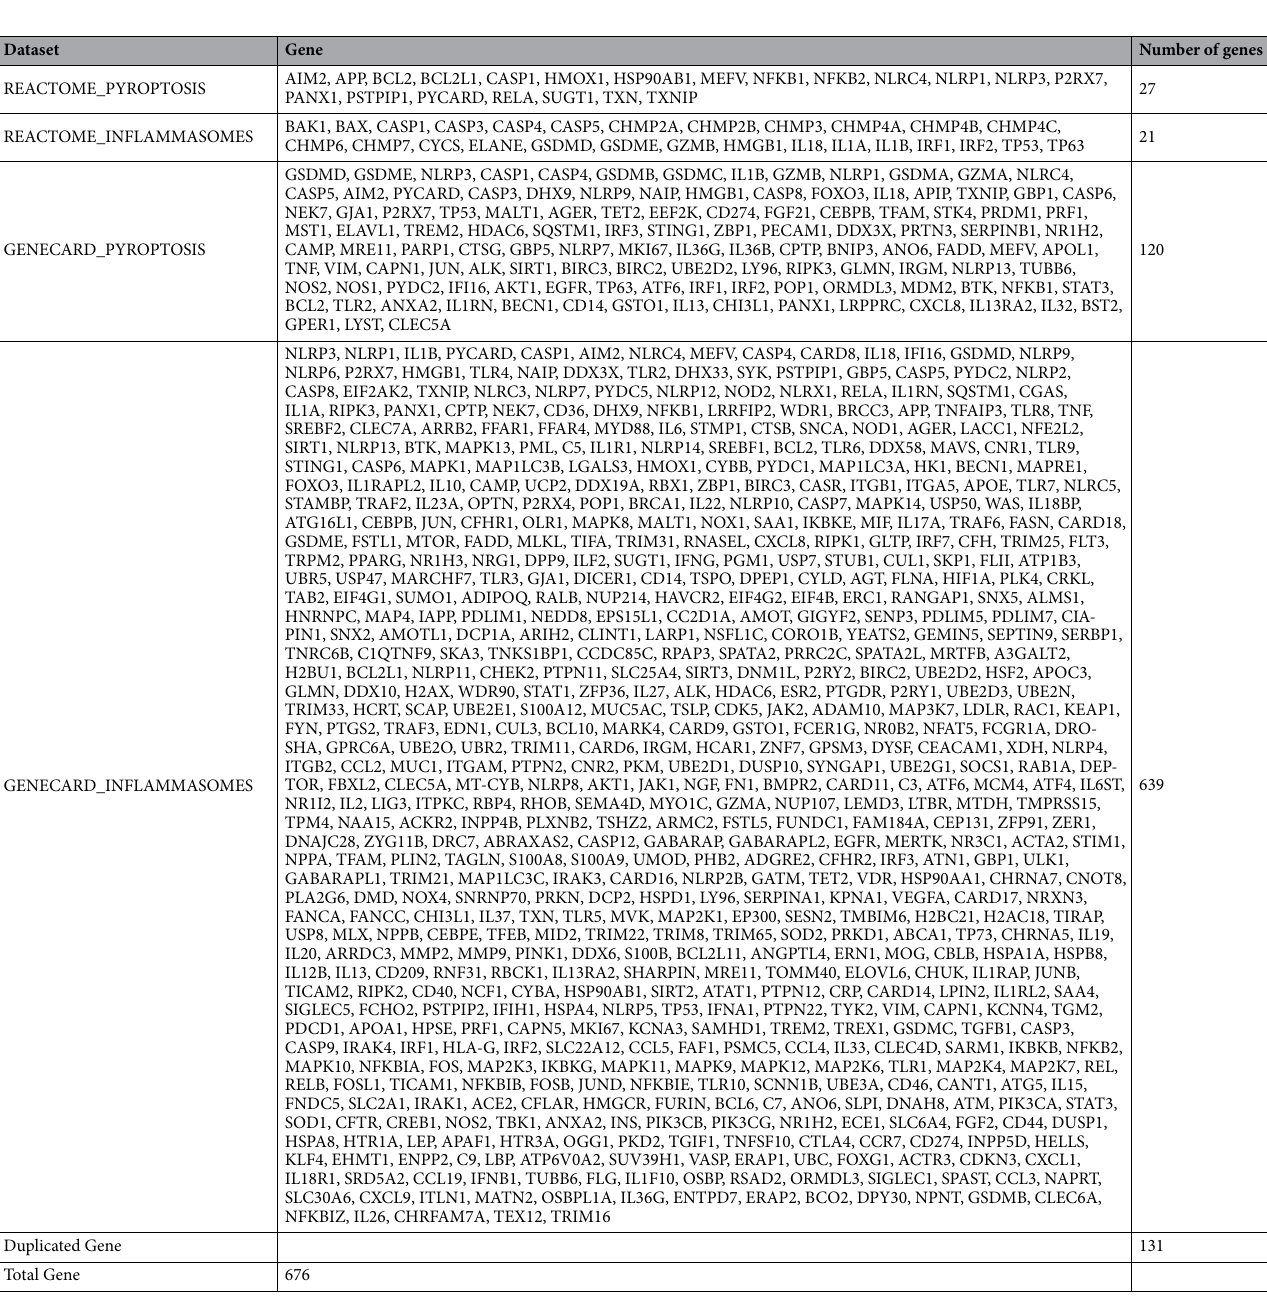
Table 1. pyroptosis and inflammasome-related